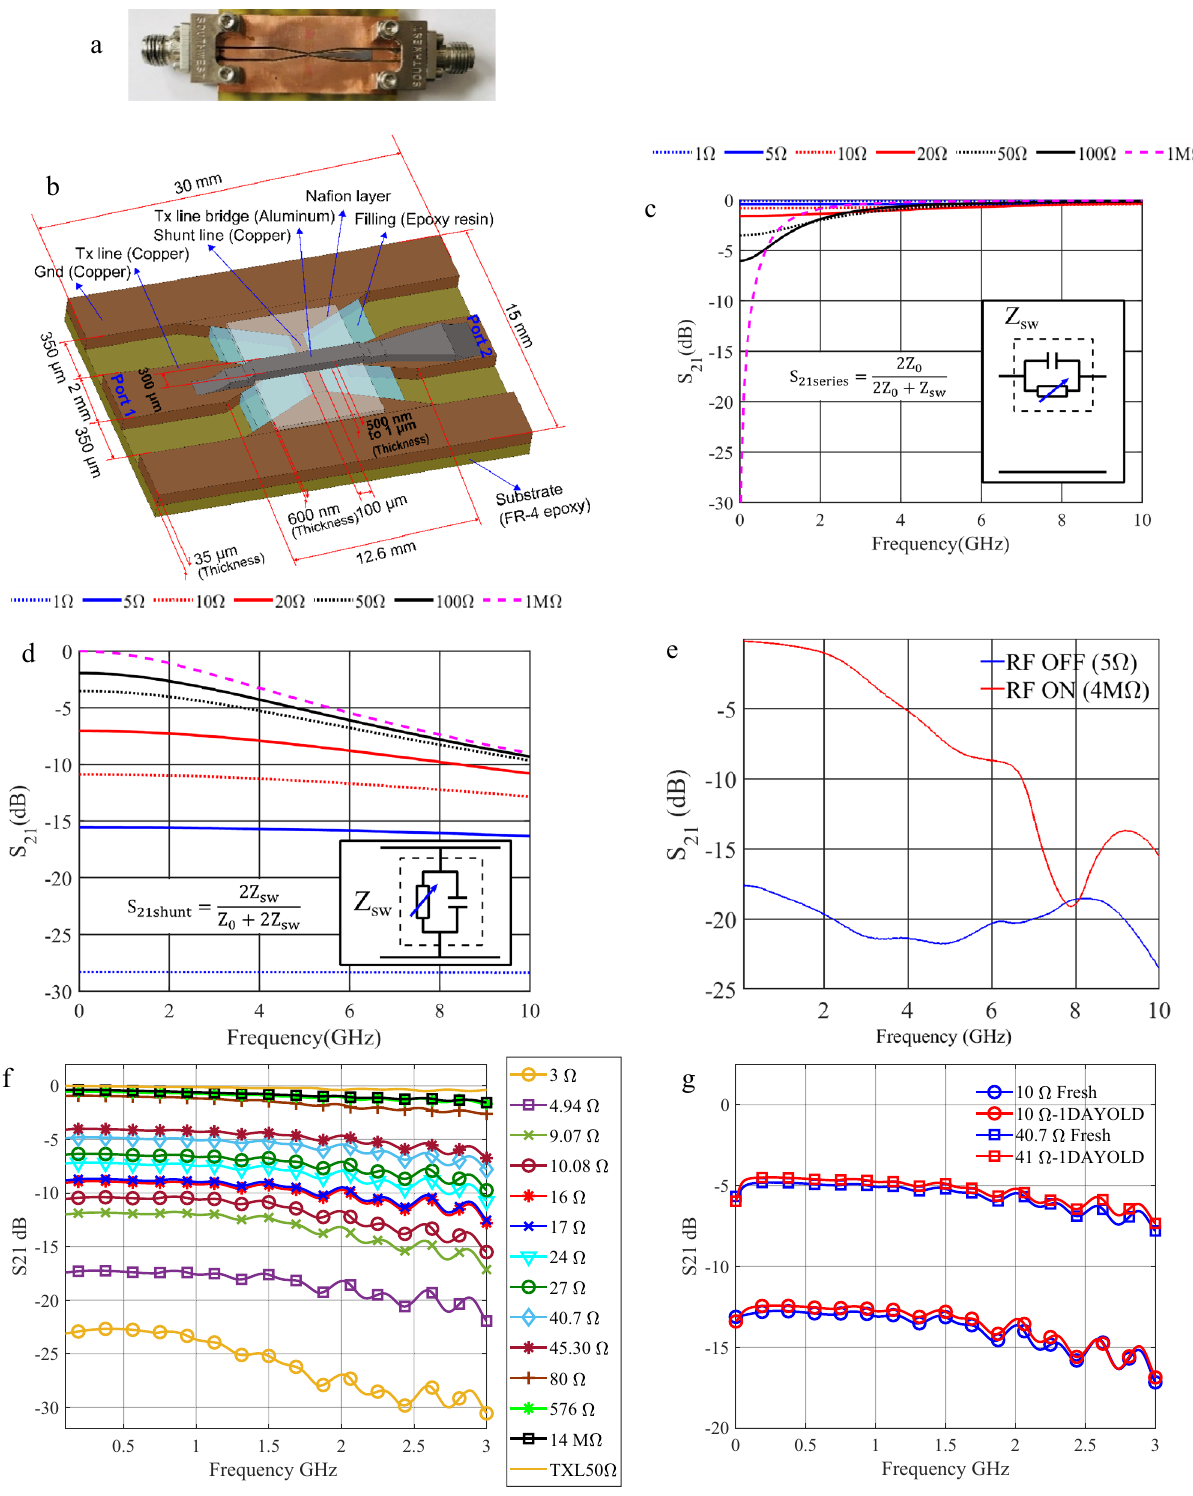
Figure 5. CBRAM based CPW shunt mode RF switch programmed using the proposed PRPA algorithm. ( a ) Photograph of fabricated device. ( b ) Topology and layer structure. ( c ) S 21 parameter model values of the CBRAM cell connected in series to a transmission line of characteristic impedance of Z 0 = 50 Ω. ( d ) S 21 parameter model values of the CBRAM cell connected in parallel (shunt) to a transmission line of characteristic impedance of Z 0 = 50 Ω. The CBRAM cell has been modelled as a shunt RC circuit of impedance Z SW in both cases ( c,d ) with C = 1681 fF. ( e ) Simulation of the S 21 parameter of the presented RF switch up to 20 GHz for ON and OFF states. ( f ) Measured RF transmission characteristics. ( g ) Measured time stability of the RF